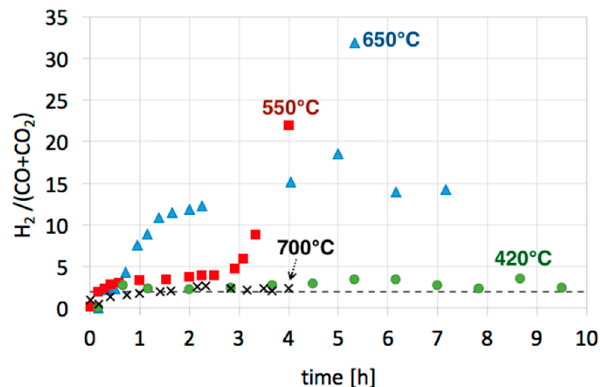
Figure 12. H 2 /(CO + CO 2 ) ratio during regeneration of Ni/CeZrO 2 at 420 °C (●), 550 °C ( ◼ ) and 650 °C ( ▲ ), and Ni-MgO at 700 °C ( ✕ ).